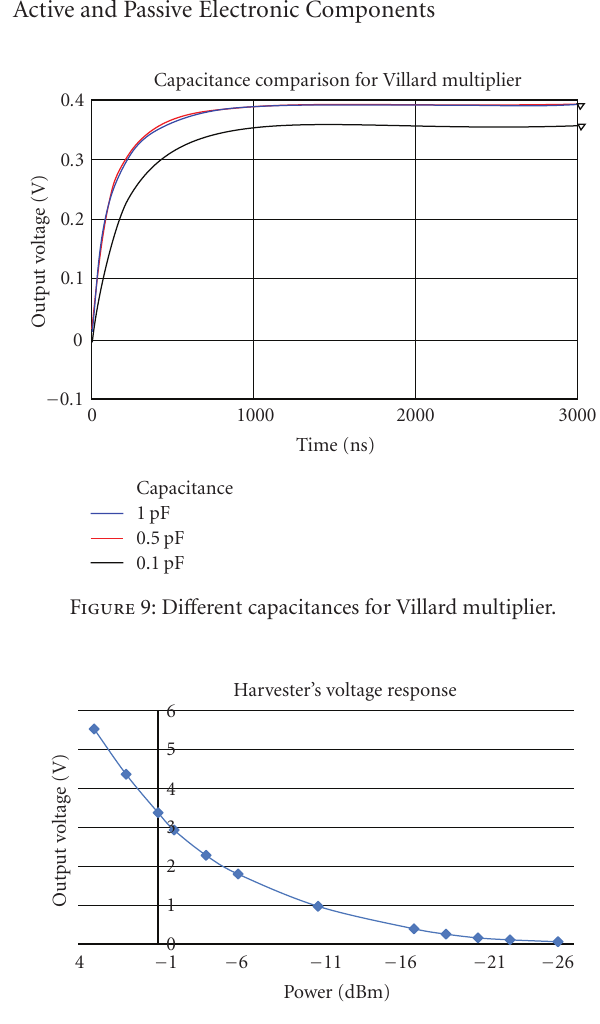
Figure 10: Harvester’s voltage response to di ff erent input powers.